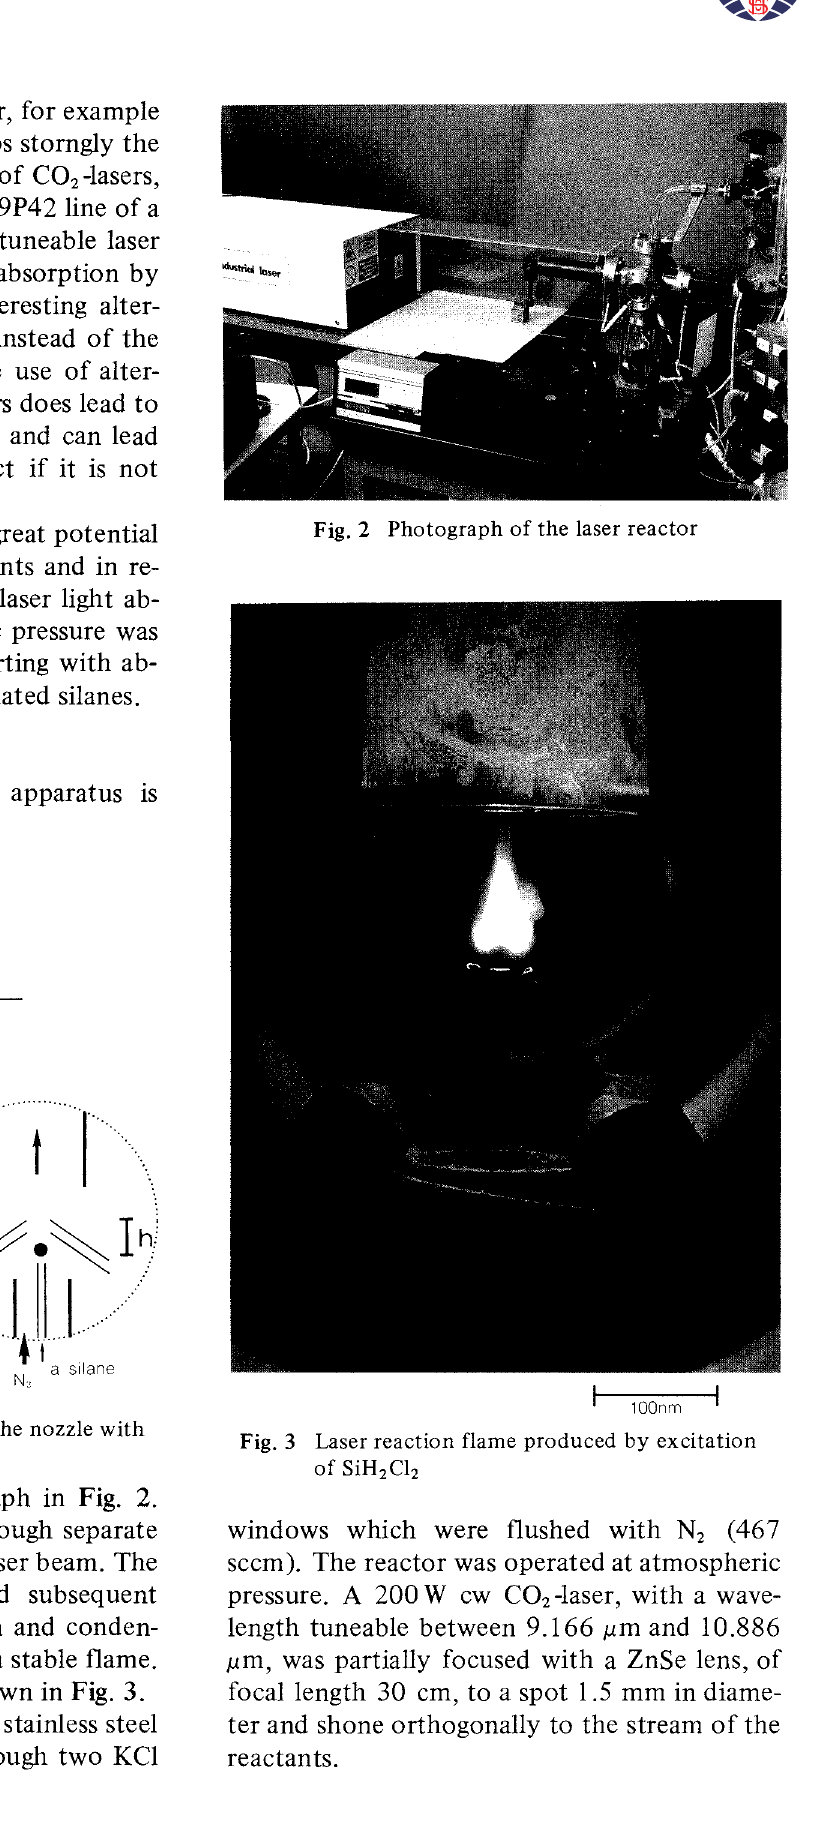
Fig. 3 Laser reaction flame produced by excitation of SiH 2 Cl 2 windows which were flushed with N (467 2 seem). The reactor was operated at atmospheric pressure. A 200 W cw C0 -laser, with a wave 2 length tuneable between 9.166 J.Lm and 10.886 J.Lm, was partially focused with a ZnSe lens, of focal length 30 em, to a spot 1.5 mm in diame ter and shone orthogonally to the stream of the